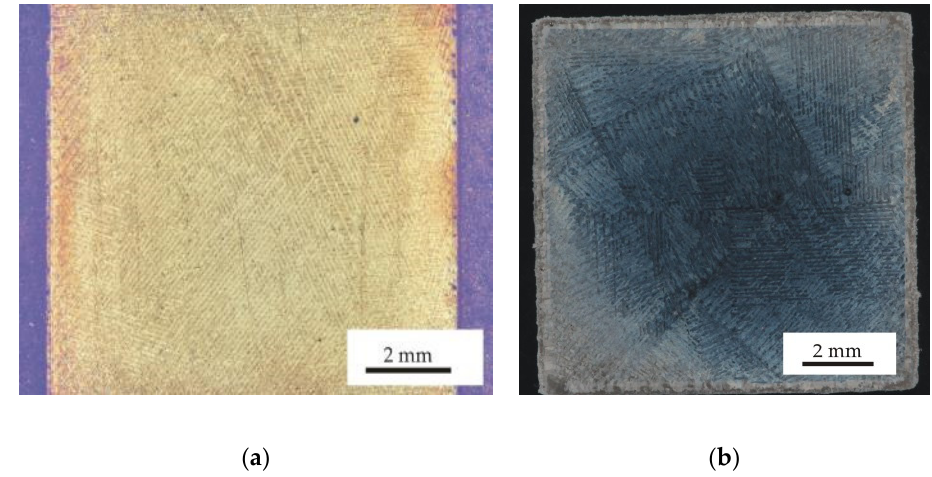
Figure 8 . ( a ) Optical microscopy OM image of sample 2 after SLM and ( b ) OM image of sample 9 after SLM, etched with Carpenter reagent.